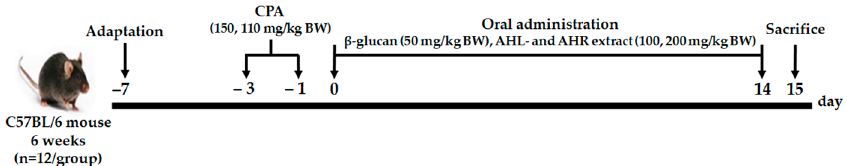
Figure 1. The experimental